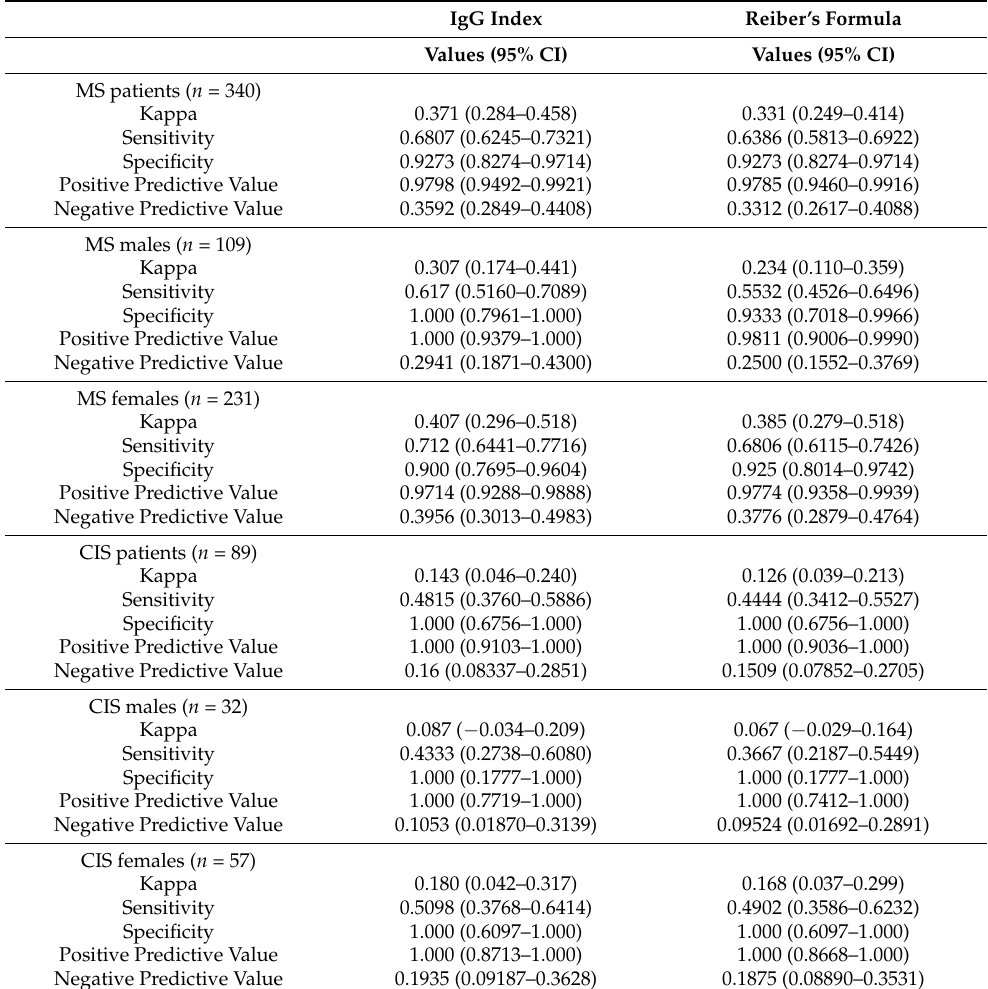
Table 5. Impact of sex on the agreement between quantitative and qualitative methods for the determination of an intrathecal IgG synthesis. The “gold standard” of the cerebrospinal fluid (CSF)- restricted IgG oligoclonal bands was used to calculate: (i) concordance through the Cohen’s kappa, (ii) sensitivity, (iii) specificity, and (iv) positive and (v) negative predictive value. Multiple sclerosis (MS) subjects (cohort 1 and cohort 2 together) and patients with the clinically isolated syndrome (CIS) (cohort 3) were both analyzed as a whole and grouped by